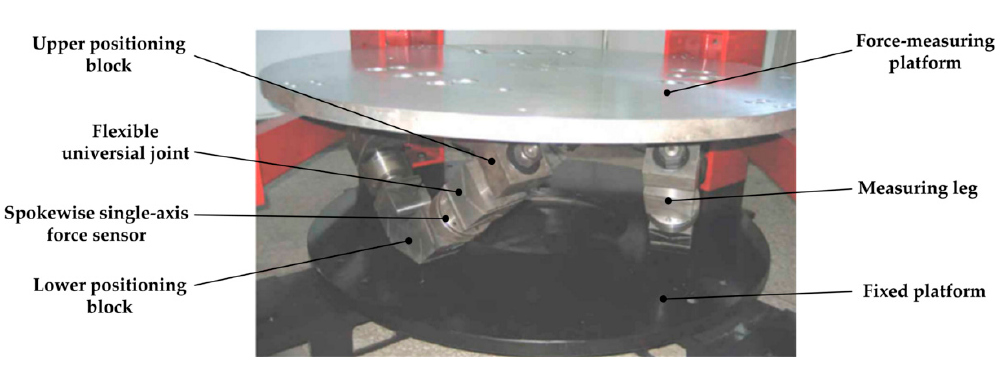
Figure 1. Physical prototype of the 6-UPUR six-axis force sensor with flexible joints.